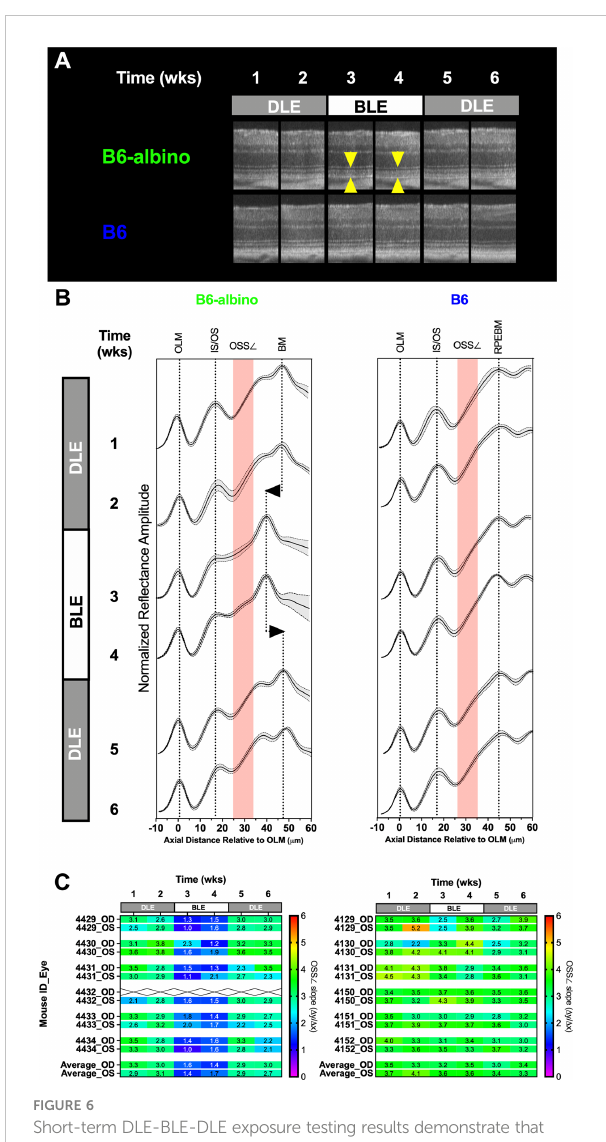
FIGURE 6 Short-term DLE-BLE-DLE exposure testing results demonstrate that light-induced photoreceptor layer outer segment changes is a non- permanent, reversible biomarker in B6-albino mice relative to B6 which are not responsive to this insult. (A) Representative SD-OCT images from a B6-albino mouse retina showing the retina before (DLE; wks 1- 2), during (BLE; wks 3-4) and after (DLE; wks 5-6) light susceptibility challenge. Yellow arrows indicate the photoreceptor layer, the region of the outer retina responsible for light absorption and phototransduction which is highly affected by BLE. Arrows bracket the region of increased OCT signal back-re fl ectivity and reduction in photoreceptor layer lamina thickness. By comparison, B6 mice are unaffected by this challenge as qualitatively no alterations to the photoreceptor layer can be observed. (B) Averaged LRPs showing the Mean ± 95%CI or both BALB/c and B6- albino are shown for each consecutive the mice were imaged under DLE-BLE-DLE conditions. The regions where the OSS ∠ ( D y/ D x) is measured is denoted by the red shaded area. The change in signal back-re fl ection and shortened photoreceptor layer thickness, as revealed by the shift in BM, is easily discerned at weeks 3 &4 for B6- albino. In comparison, averaged LRPs from B6 mice show no changes in signal back-re fl ectivity or movement of the RPEBM. (C) A heat-map of individual mice (OD & OS) showing the mean OSS ∠ values averaged from temporal, nasal, superior and inferior regions. B6-albino OSS ∠ are reduced by ~2 (50%) slope units within one week of being switched from DLE to BLE. This reduction in slope was very signi fi cant (Adj. P<0.0001) for BLE at both weeks 3 & 4. B6 mice as a group showed a decreasing trend in the average OSS ∠ but this change was not statistically signi fi